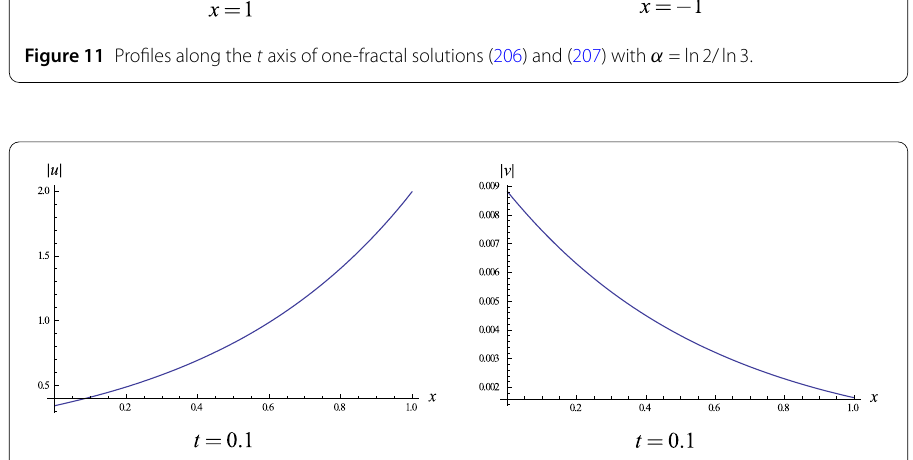
Figure 12 Profiles along the t axis of one-fractal solutions (206) and (207) with α = ln2/ln3.